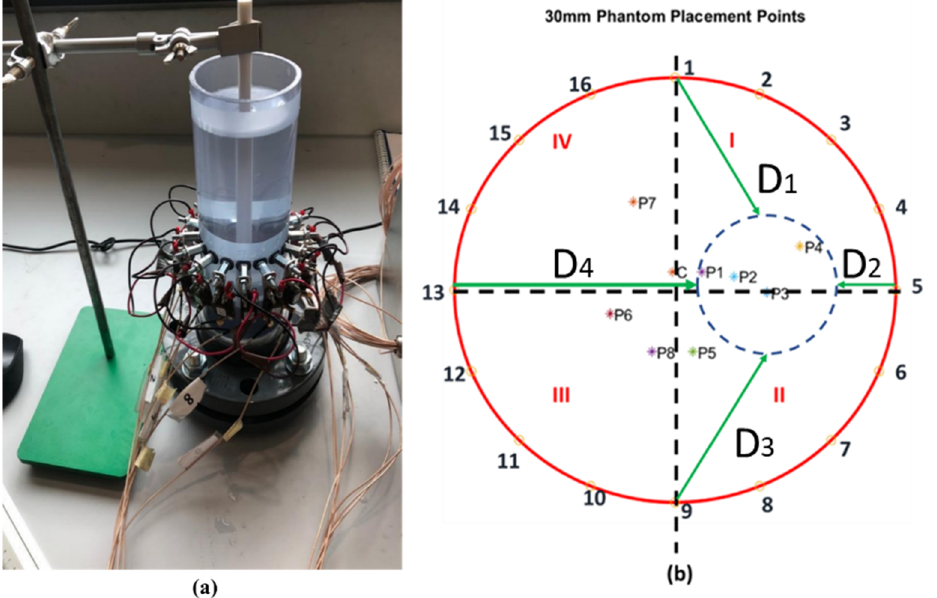
Figure 5. ( a ) Placement of 20 mm phantom inside the physical sensor ( b ) Procedure illustration for distance measurement from positions D 1 , D 2 , D 3 , and D 4 . The figure also shows the 9 positions used for the static measurements.